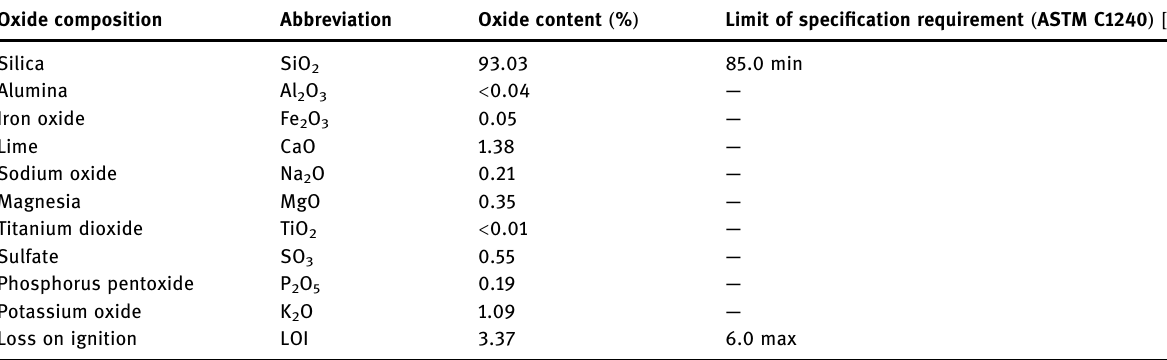
Table 7: Chemical properties of micro silica